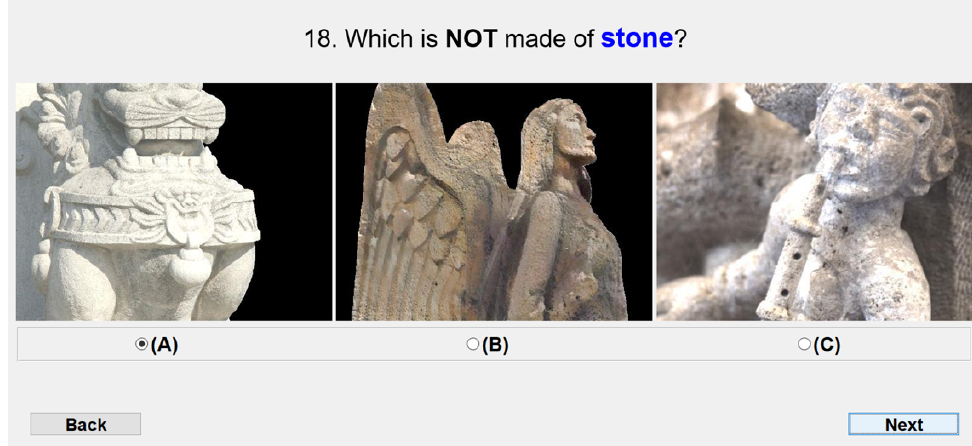
Figure 11. Human perceptual study interface: 70% of the participants chose ( A ), 18% chose ( C ), while the image generated using our approach ( B ) got only 12% of the